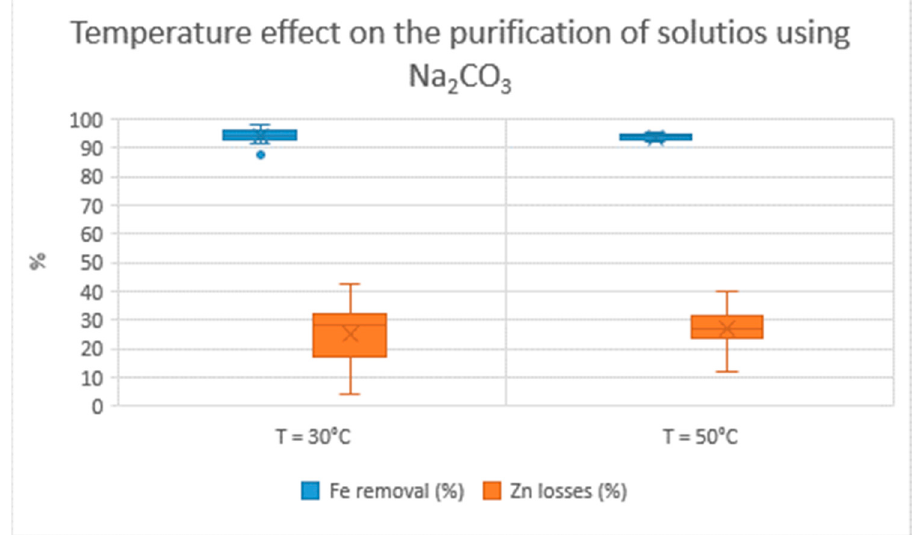
Figure 16. Temperature effect on the purification of solutions using Na 2 CO 3 .